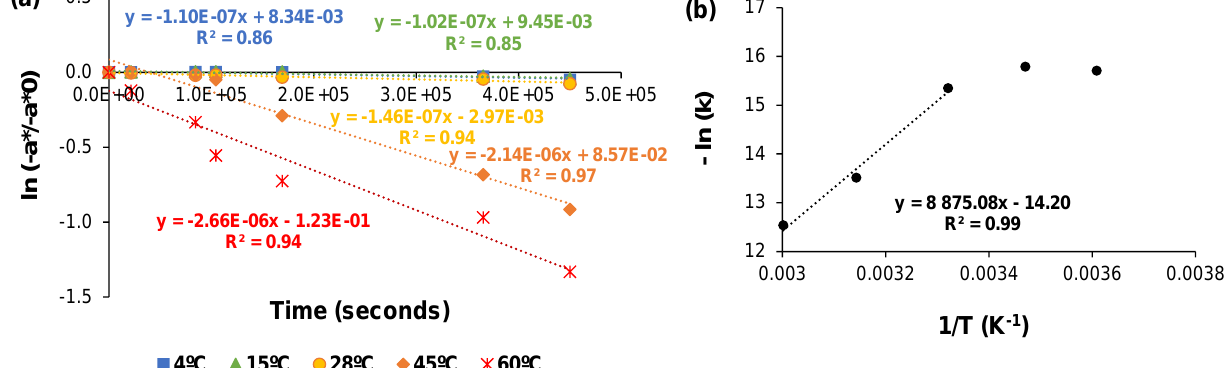
Figure 8. ( a ) First order plot of color ( − a*) degradation in C. vulgaris ethanolic solution at different temperatures; ( b ) Arrhenius plot for color loss of ethanolic solutions of C. vulgaris chlorophylls.